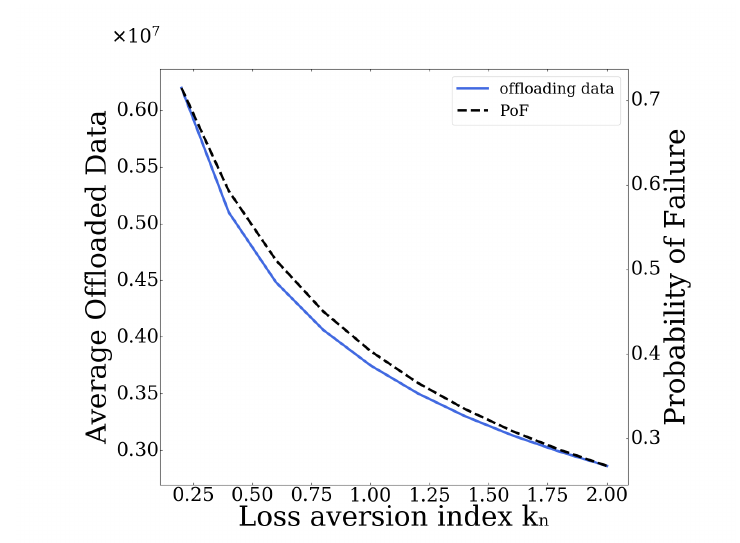
Figure 13. Average offloading data and PoF vs. loss aversion index k n